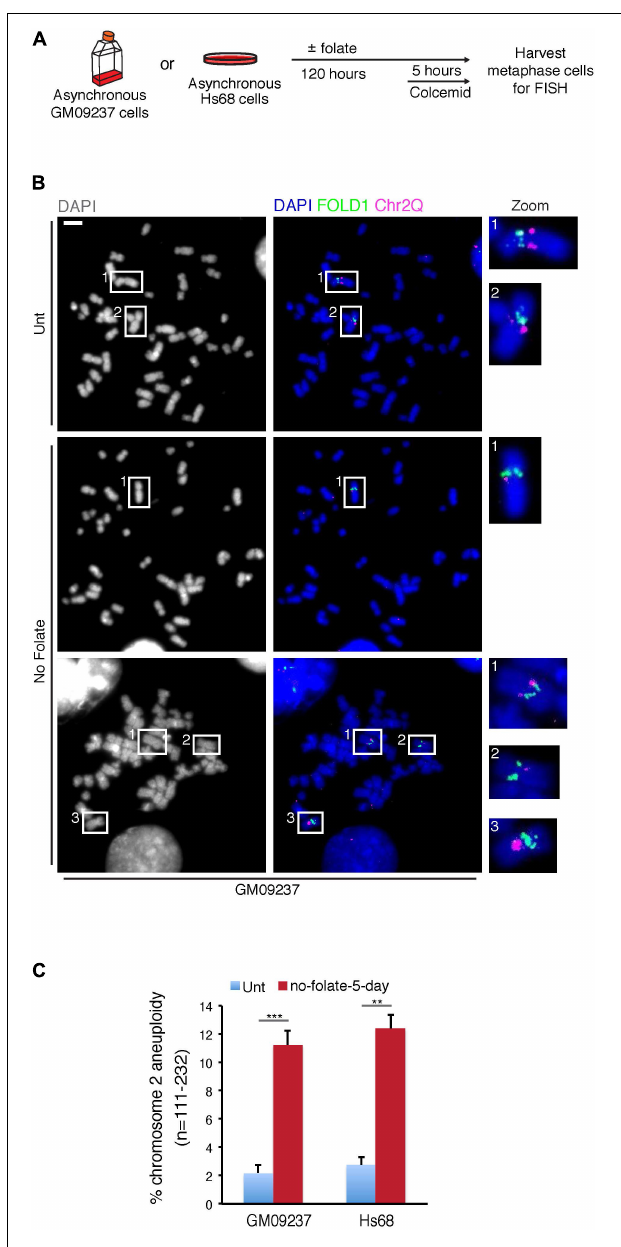
FIGURE 4 | Extended folate deprivation causes Chr2 aneuploidy. (A) Experimental workflow for the analysis of metaphase chromosomes following folate deprivation for 5 days. (B) Representative images and (C) quantification of chromosome 2 aneuploidy in GM09237 and Hs68 cells. Selected regions (white boxes) are shown as zoomed images on the right. N : number of metaphase spreads analyzed. Scale bar, 5 µ m. Data are means of at least three independent experiments. Error bars represent SDs. (** p < 0.01; *** p <